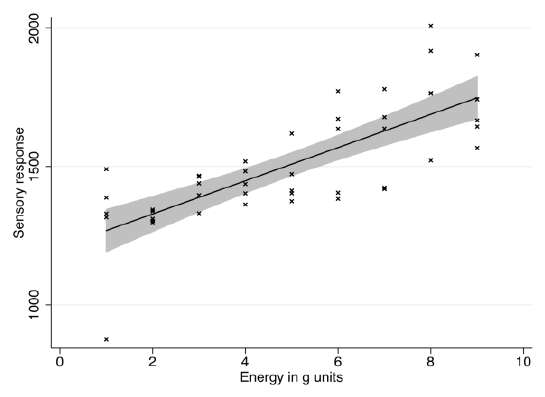
Figure 4. Each data point represents a sensor reading on the y-axis dependent on different levels of potential energy (just before the object starts falling) or, equivalently, kinetic energy (just before the impact) on the x-axis. Energy is plotted as multiples of acceleration of gravity g, and ranges between 1 g and 9 g. The line corresponds to the data’s best fit using a linear regression model. The grey area is the 95% confidence interval.